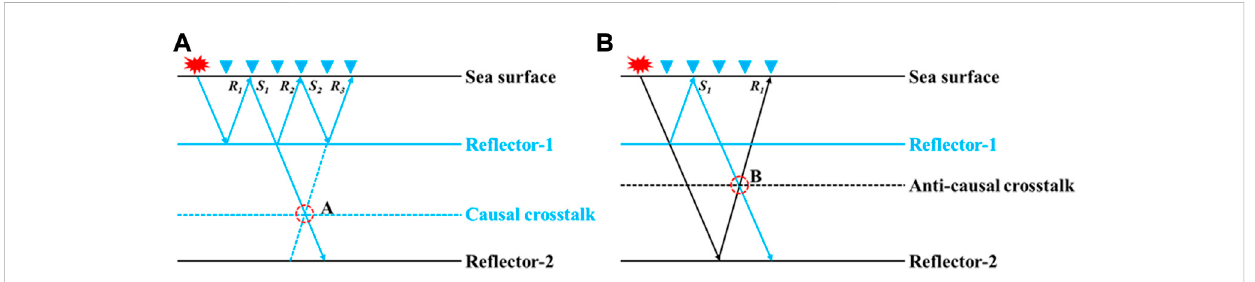
FIGURE 1 The ray paths diagrams for the two types of crosstalk. (A) The diagram of trajectories for causal crosstalk, (B) the diagram of trajectories for anti- causal crosstalk. In (A) , The virtual source S 1 (recorded primary re fl ections carried with information of re fl ector-1 as the source wave fi eld) and receiver wave fi eld R 3 (second order multiple) can generate causal crosstalk at position (A) . In (B) , the virtual source S 1 and receiver wave fi eld R 3 (recorded primary re fl ections carried with information of re fl ector-2 as the receiver wave fi eld) can generate anti-causal crosstalk at position (B)